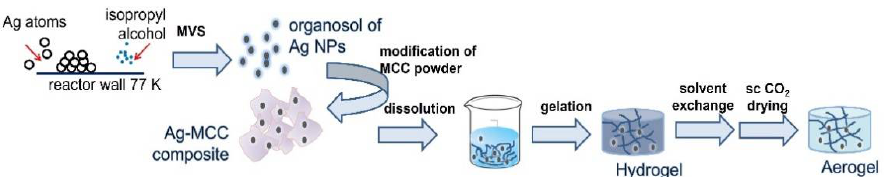
Figure 1. Scheme illustrating the main steps of preparation cellulose-based composites with Ag NPs in powdered and gel form.